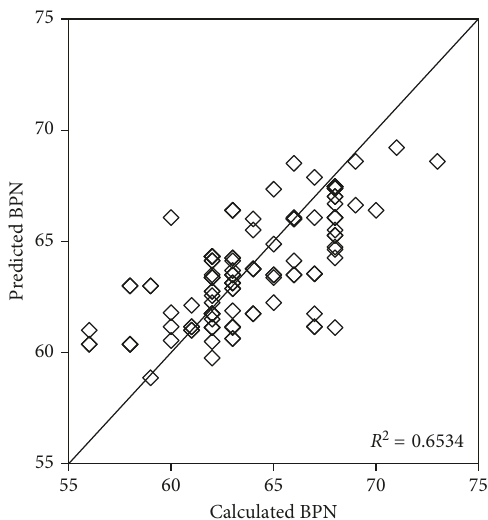
Figure 6: The comparison of the calculated BPN values with the predicted BPN values from the MR model for all Table 4: Performance indices ( R 2 , RMSE, MAE, and VAF) of the ANN and MR models. Model